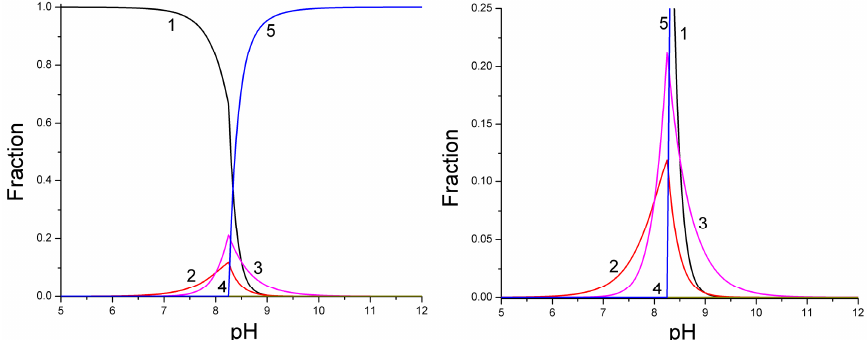
Figure 2. Dependence of the Pr(III) species fraction on pH (concentration of Pr(III): 1.77 × 10 − 6 M) (1, Pr 3+ ; 2, PrOH 2+ ; 3, Pr(OH) 2+ ; 4, Pr 2 (OH) 24+ ; 5, Pr(OH) 3 ).